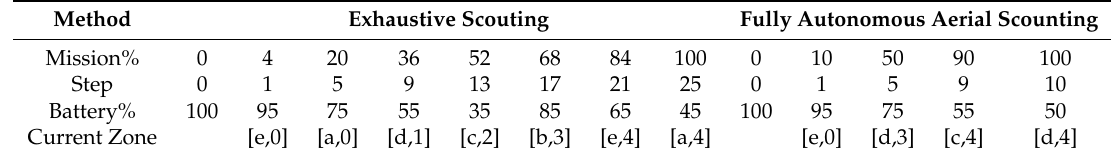
Table 1. The benefits of the fully autonomous aerial scouting captured by empirical traces of battery drain.